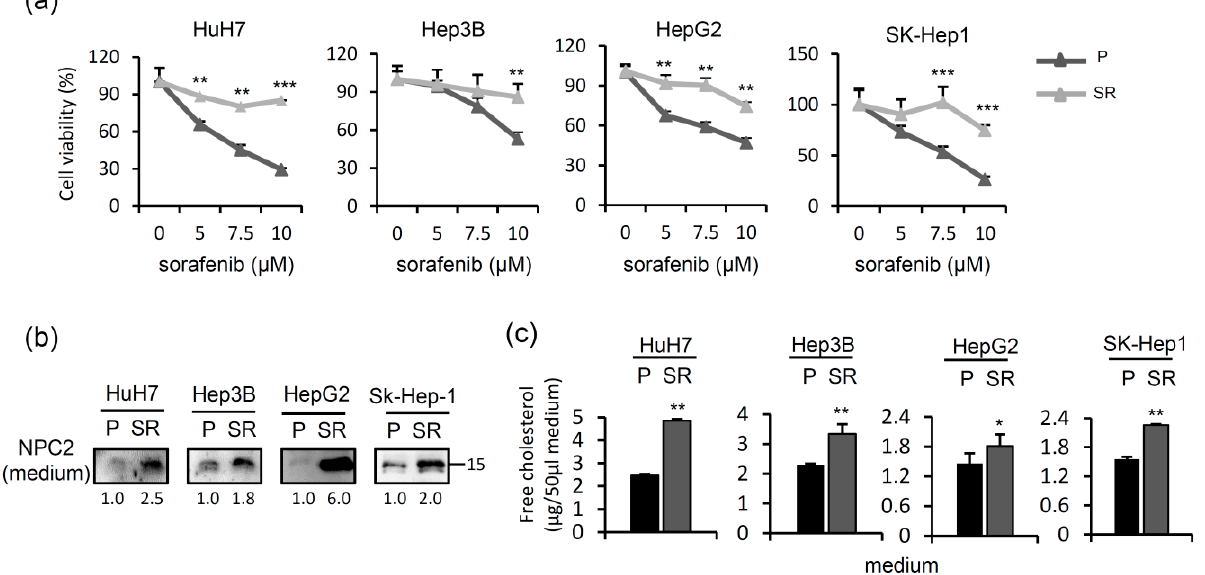
Figure 6. Niemann-Pick type C2 (NPC2) and free cholesterol levels increase in culture supernatant of sorafenib-resistant cells. ( a ) Parental and established sorafenib-resistant cells were treated with indicated doses of sorafenib for 48 h, and cell viability was assessed with an MTT assay. ( b , c ) NPC2 and free cholesterol levels in cell culture supernatants of parental and sorafenib-resistant cells. * p < 0.05, ** p < 0.01, *** p < 0.001 compared to parental cells. These experiments were repeated two times with similar results.